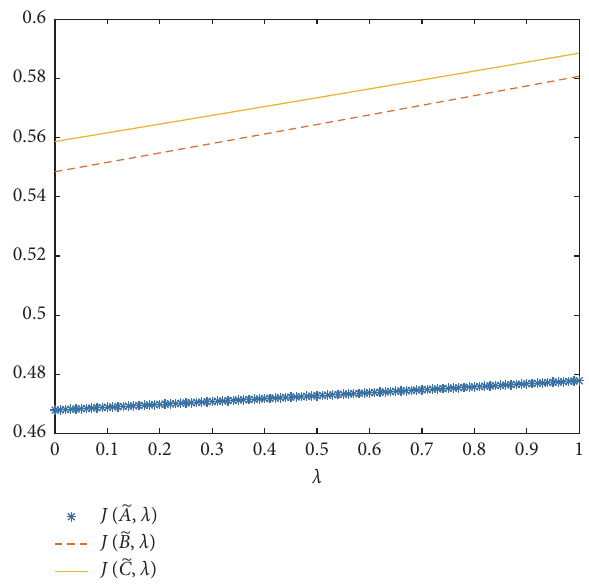
Figure 13: J ( 􏽥 A, λ ) , J ( 􏽥 B, λ ) , and J ( 􏽥 C, λ ) score functions from Nayagam et al.’s [28] method.